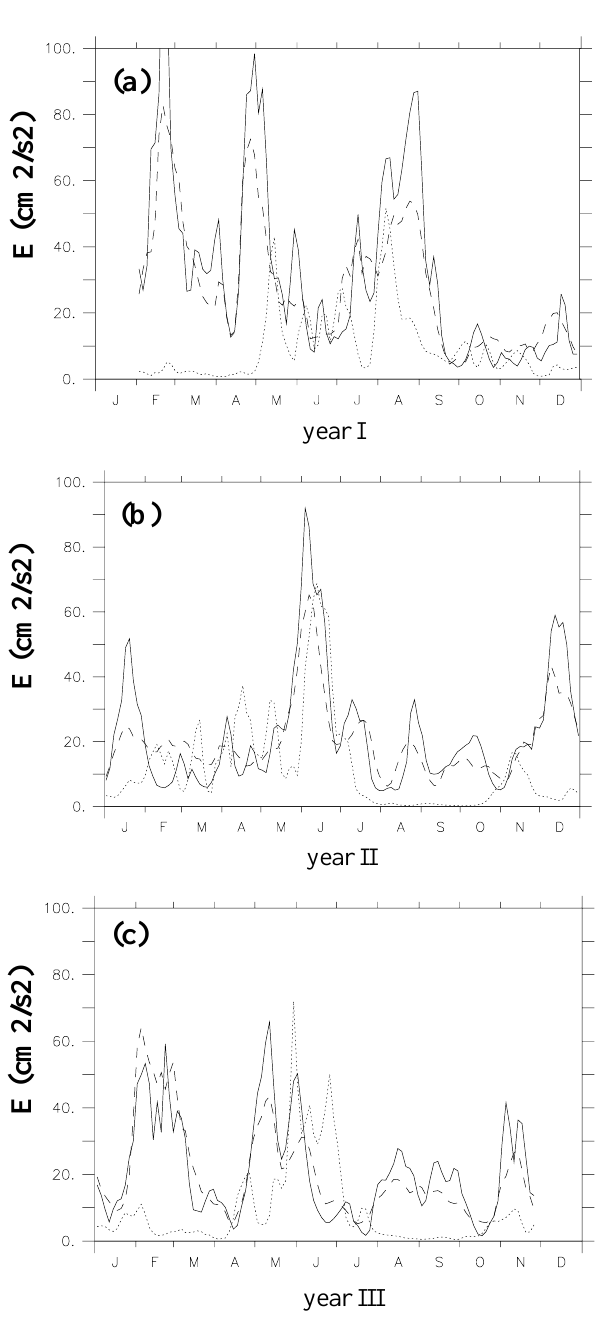
Fig. 10. Eddy kinetic energy (in cm 2 /s 2 ) calculated from the RM velocity field at 100m depth, and averaged horizontally over three different areas indicated in Fig. 8: (1) the Gulf of Lions’